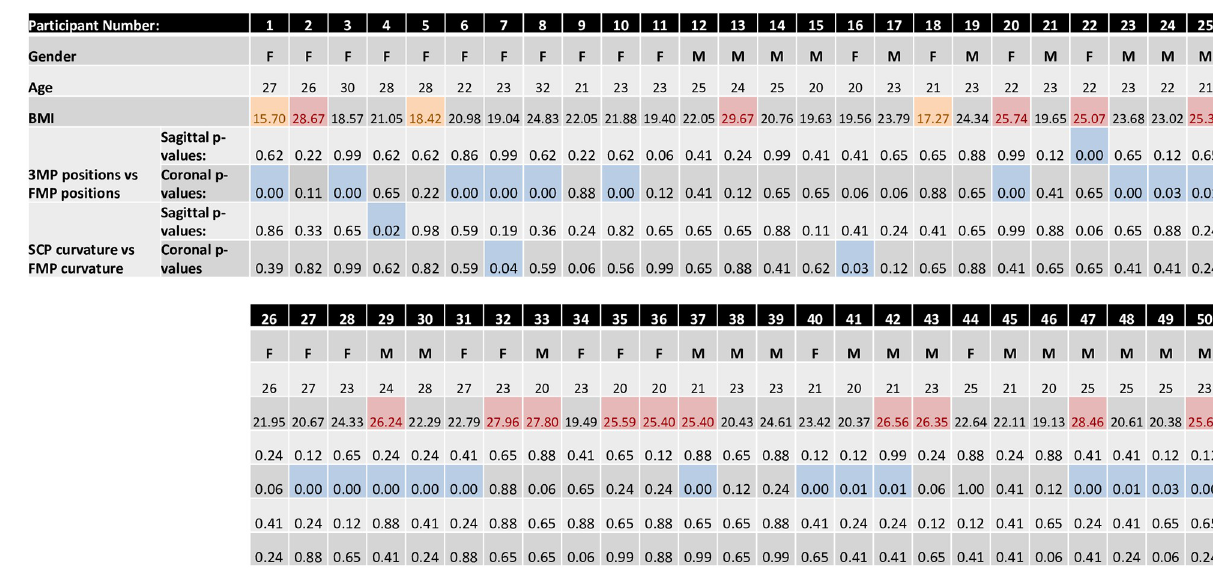
Fig 6. Participant demographics and KS test p-values of 3MP vs FMP and SCP vs FMP. P-values greater than 0.05 indicate no significant difference between the two profiles. Values less than 0.05 (highlighted in blue) indicate significant difference between the two compared profiles. Gender is listed such that F = Female, and M = Male. Age is given as a whole integer at the time of scanning. BMI is classified as underweight (orange), healthy weight, and overweight (red).